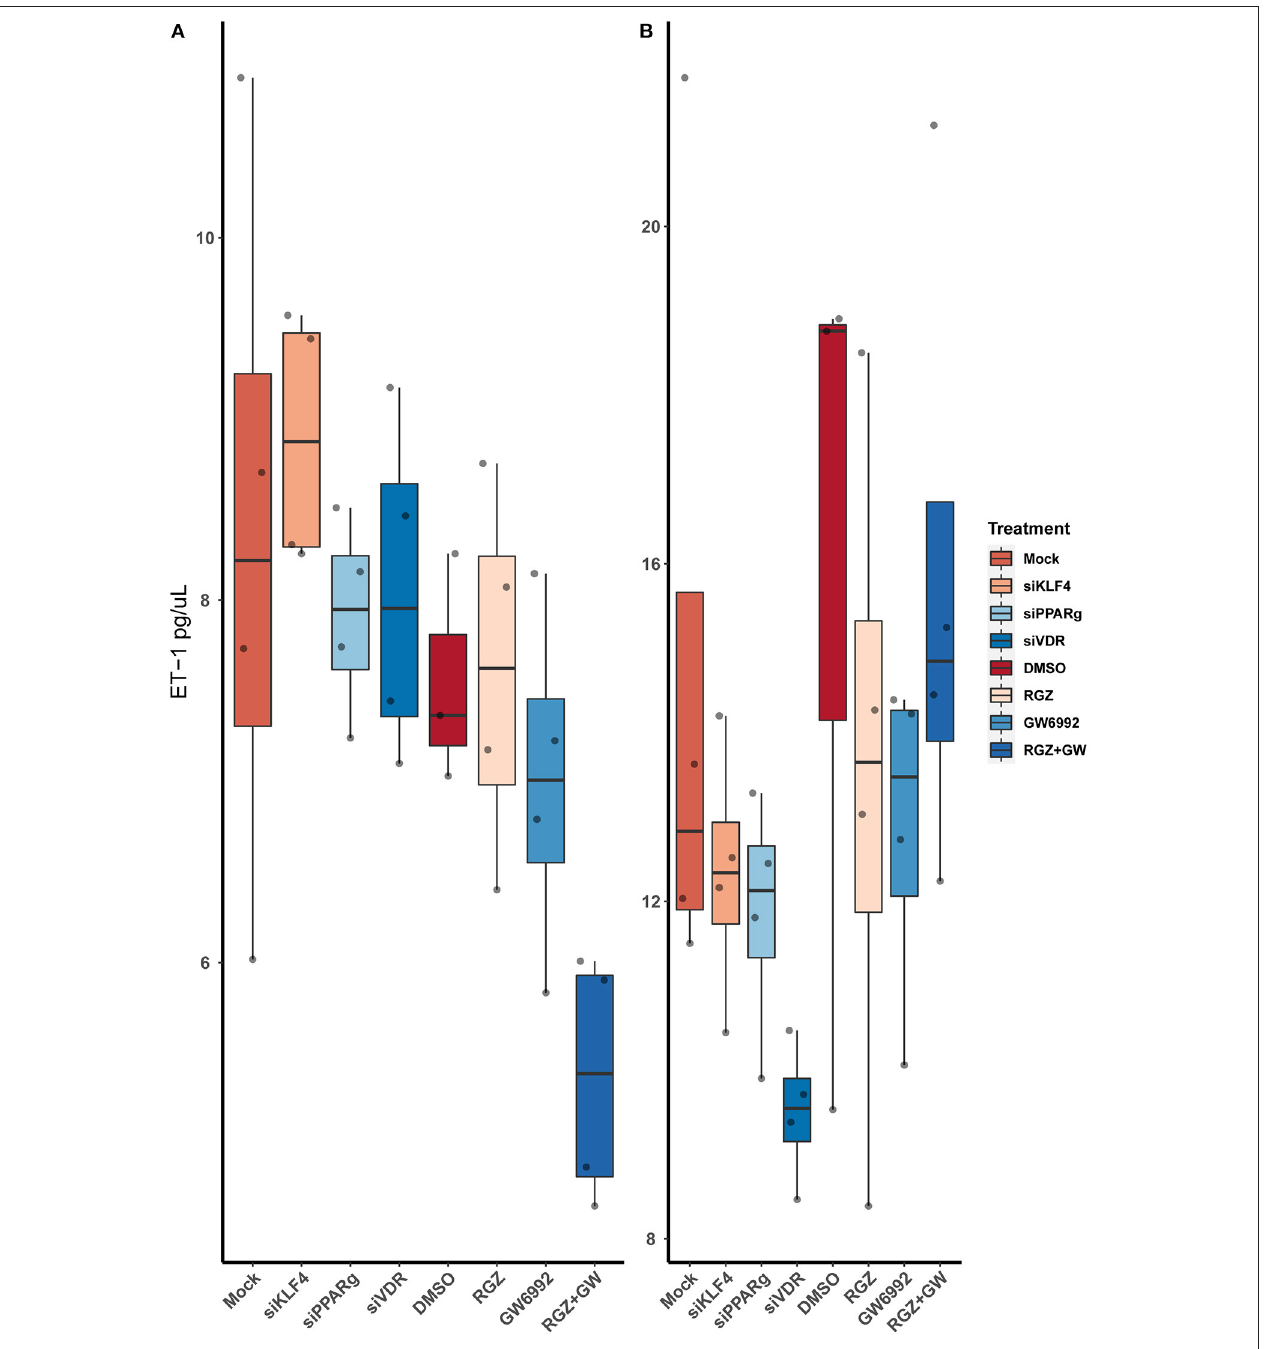
FIGURE 7 | Quantification of ET-1 by sandwich ELISA. (A) Raw values. (B) After normalizing against the total protein from the well. Data are shown as box plots representing median ± quartiles. Dots represent biological replicates ( n = 4). A Kruskal-Wallis test with a Dunn’s correction was used for statistical analysis.